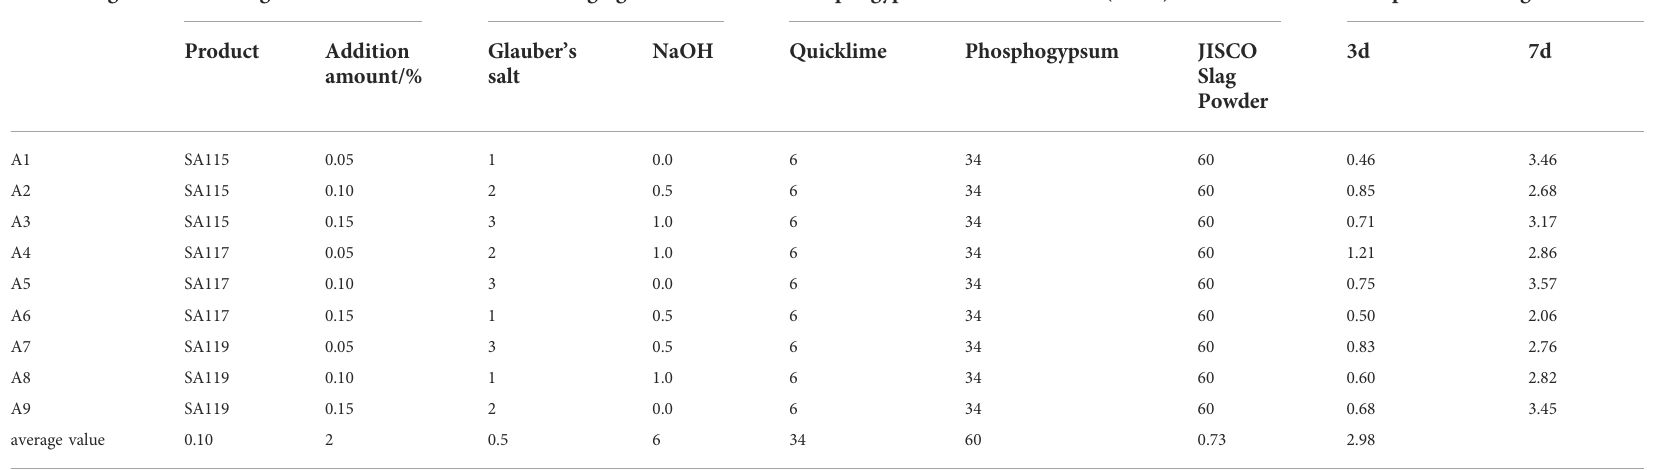
TABLE 3 Orthogonal test results of fi lling body